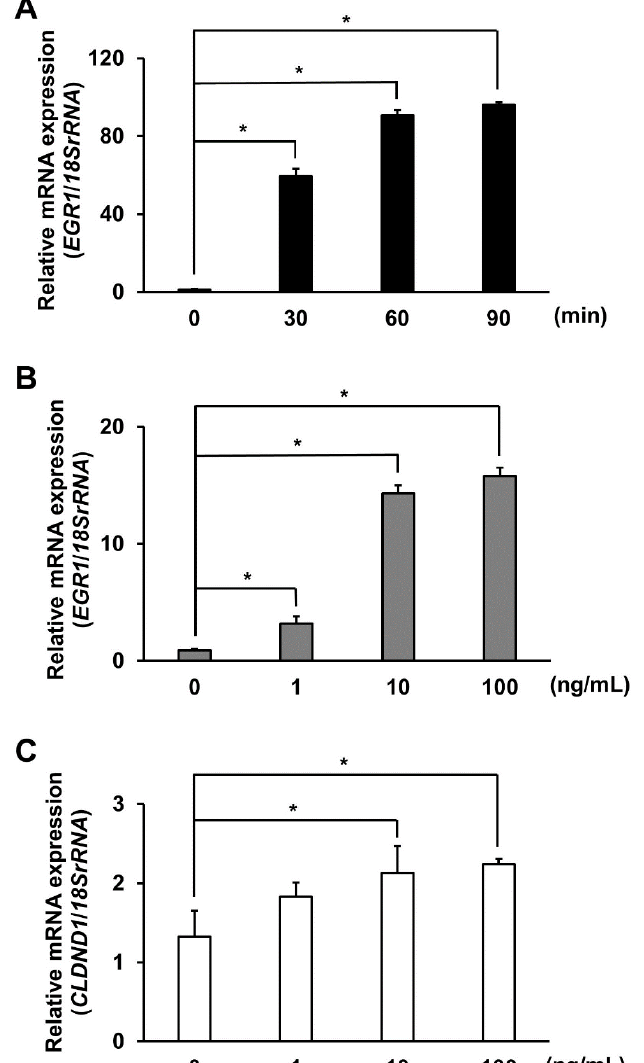
Figure 4. Effect of EGF treatment on CLDND1 expression. ( A ) HBECs were cultured in the presence of 0.1% FBS and treated with 10 ng/mL EGF for 0, 30, 60, or 90 min. mRNA levels of EGR1 were measured using qRT-PCR, which was increased by EGF treatment as a positive control. ( B ) HBECs were cultured in the presence of 0.1% FBS and treated with 0, 1, 10, or 100 ng/mL EGF for 60 min. mRNA levels of EGR1 were measured using qRT-PCR. ( C ) HBECs were cultured in the presence of 0.1% FBS and treated with 0, 1, 10, or 100 ng/mL EGF for 60 min. mRNA levels of CLDND1 were measured using qRT-PCR. 18S rRNA was used for internal correction. Results are expressed as means ± SE, n = 3, * p <